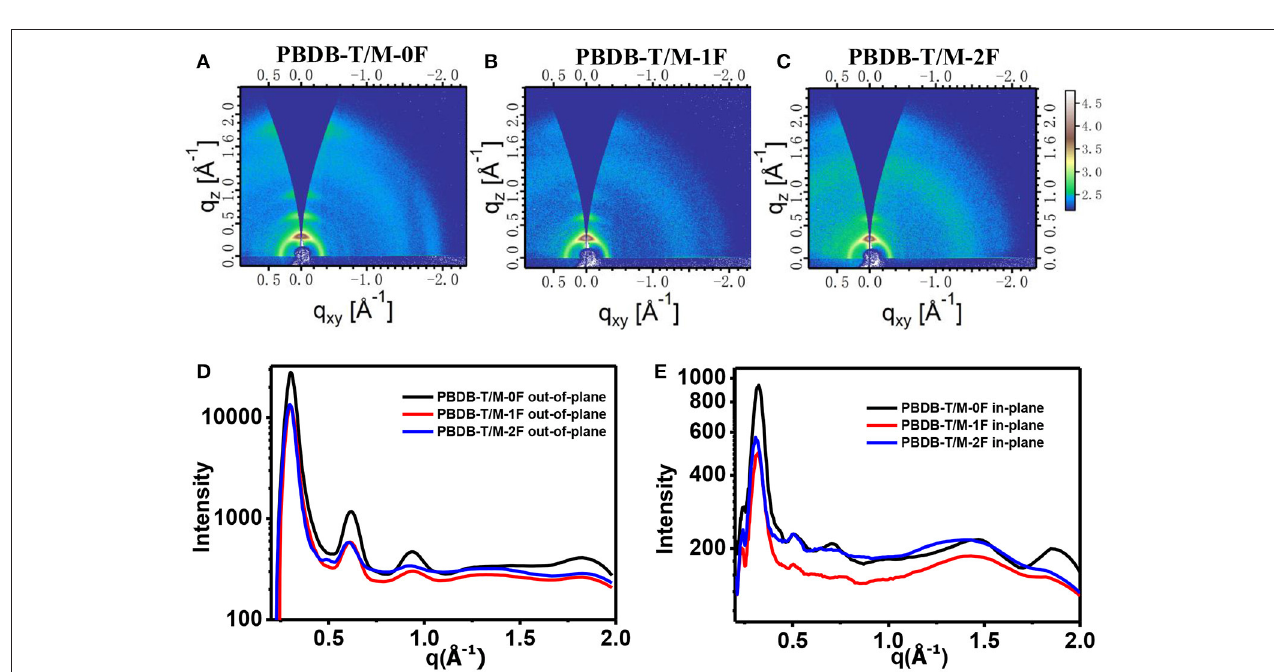
FIGURE 6 | 2D GIWAXS patterns of PBDB-T/ M-0F (A) , PBDB-T/ M-1F (B), and PBDB-T/ M-2F (C) blend film. Out-of-plane (D) and in-plane (E) cuts of the corresponding 2D GIWAXS patterns.